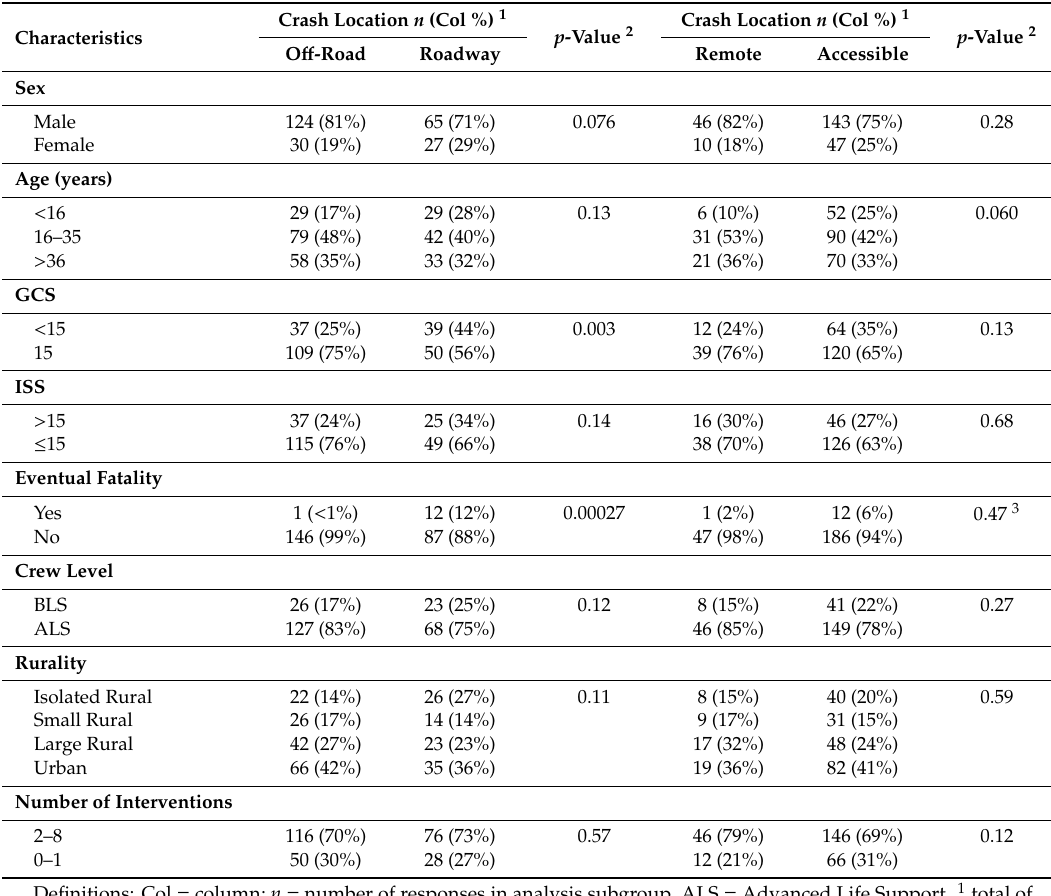
Table 2. Comparison of all-terrain vehicle crash patients transported via emergency medical services ground ambulance by crash location (2004–2014): O ff -road (N = 166) versus roadway (N = 104) and remote (N = 58) versus accessible crash location (N =